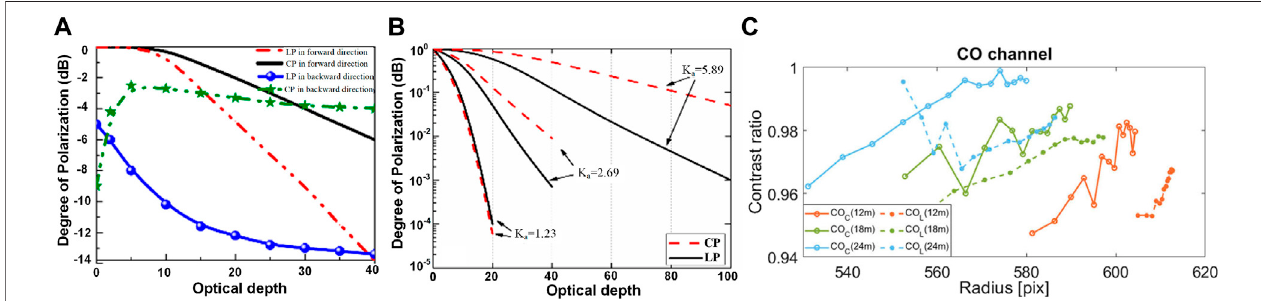
FIGURE 7 | DoP as a function of optical depth in water with different diameter particles; (A) 2 μ m particle; (B) the size parameter (ka) varies (reprint from Elsevier: Applied Sciences [47], copyright 2021). (C) Comparison of the ratio of Co channel with respect to the intensity signal as a function of the radius of the intensity pro fi le of the source image for circular (solid lines) and linear (dashed lines) polarizations at three visibilities: 12, 18, and 24 m (reprint from OSA: Optics Letters [89], copyright 2022).